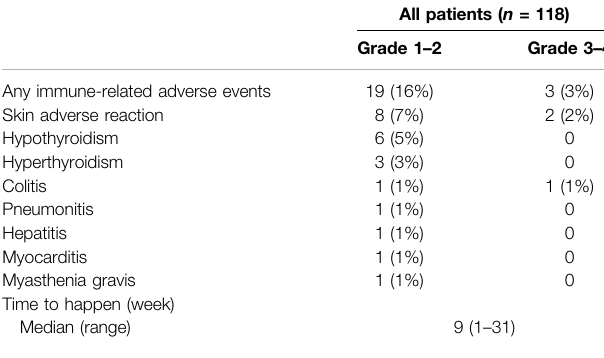
TABLE 3 | Immune-treatment adverse events occurring in